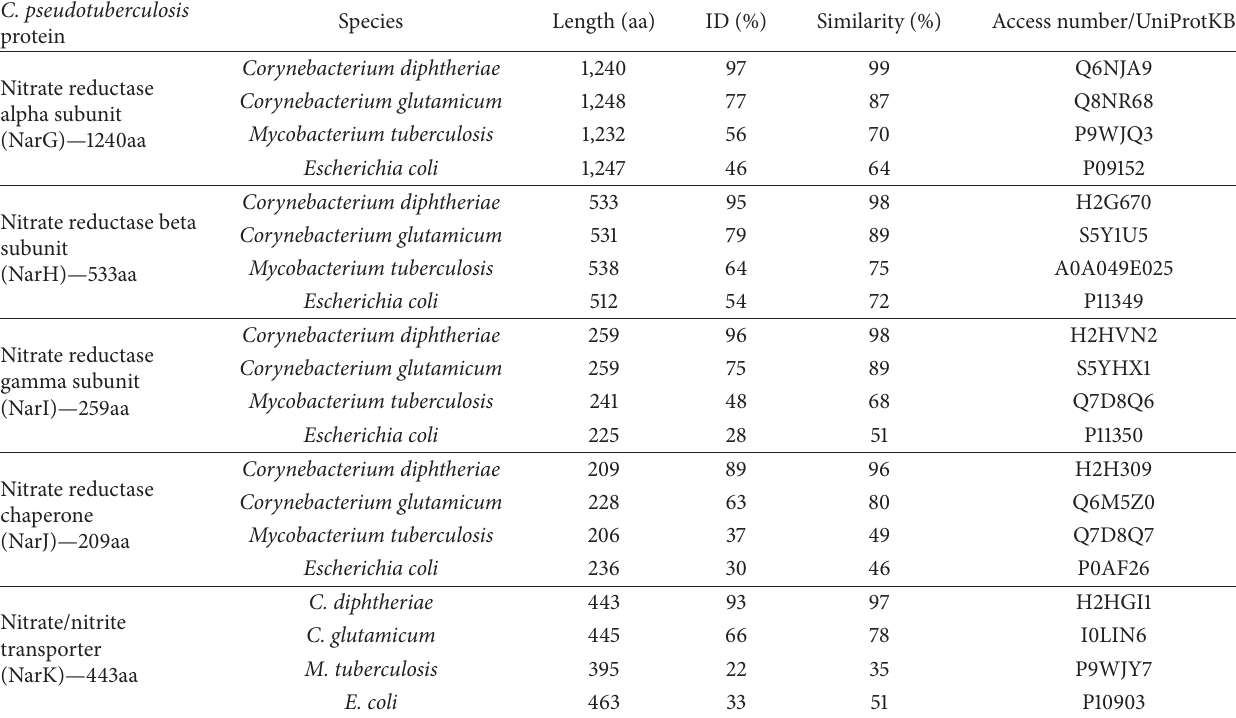
Table 2: Similarity sequence analysis of narKGHJI gene clusters of C. pseudotuberculosis